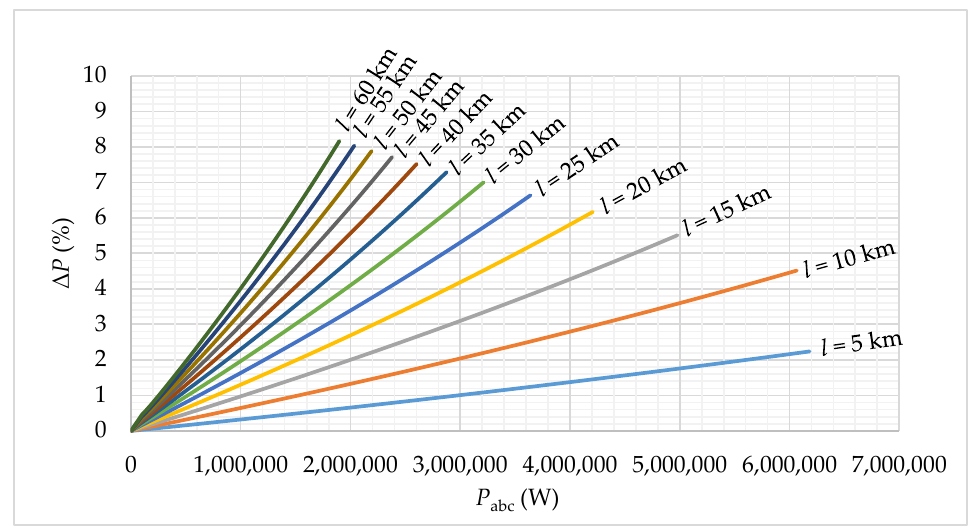
Figure 7. The dependence of increasing APLs from three-phase active power consumption for ACSR 95 / 15 with consideration of voltage dip.